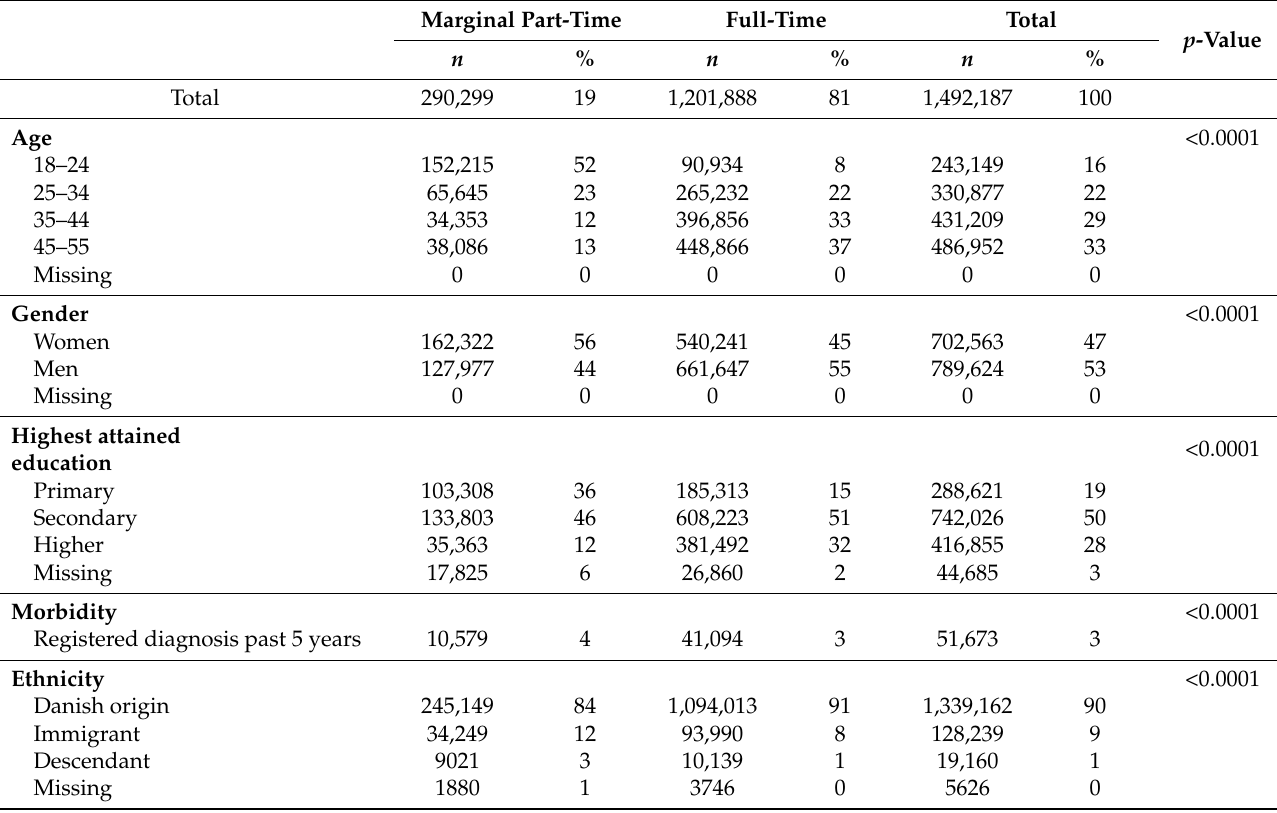
Table 1. Characteristics of ( n = 1,492,187) employees in Denmark working marginal part-time (<15 h per week) or full-time (32–40 h per week) between 1 September and 30 November